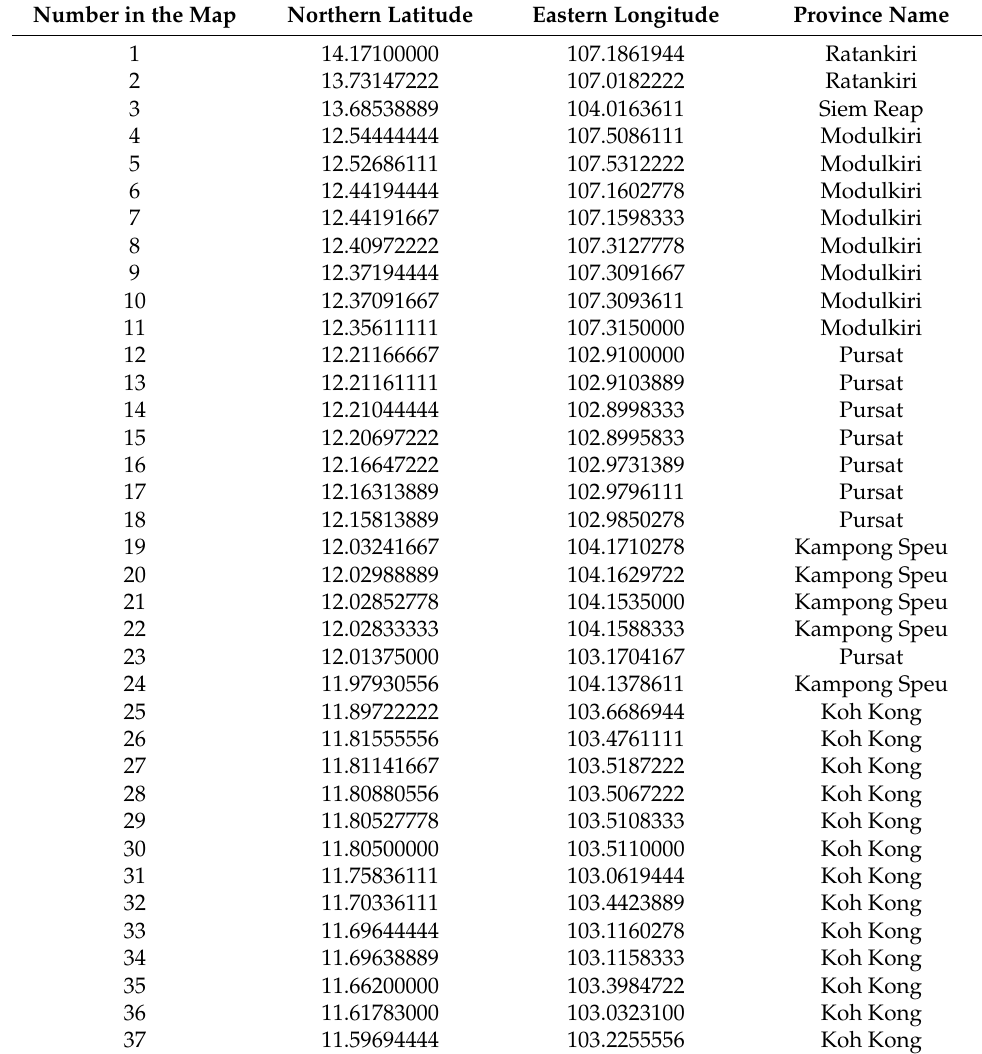
Table 2. The collecting localities coordinates and their belonging to the province. Number in the